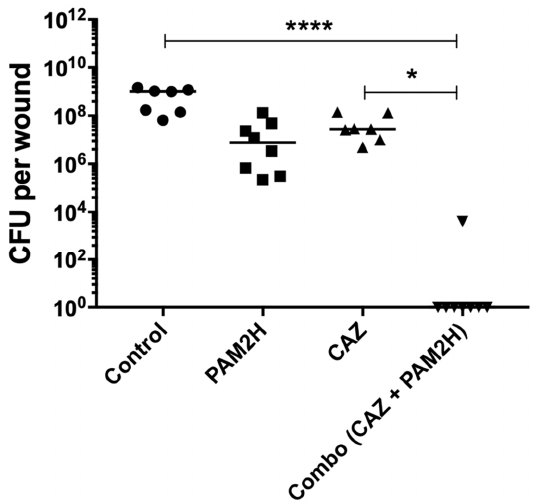
Figure 3. Colony forming units obtained from excised wound tissue on day 4 post treatment. * p < 0.05, **** p < 0.0001.